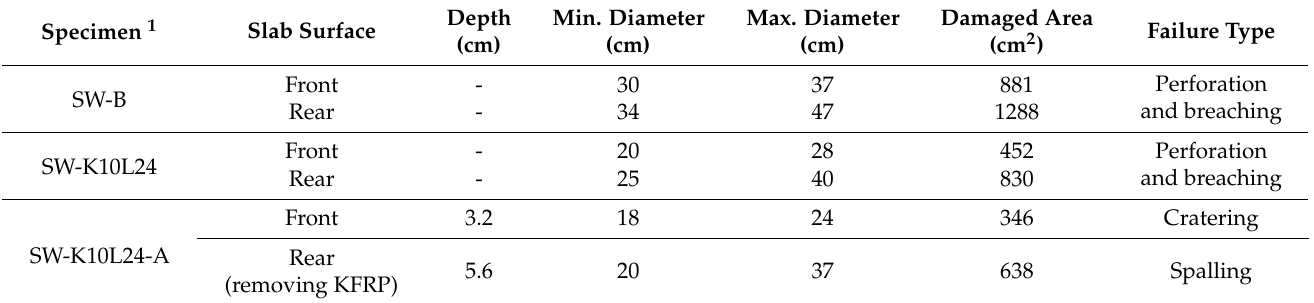
Table 11. Failure types and external damage measurements of the benchmark and KFRC